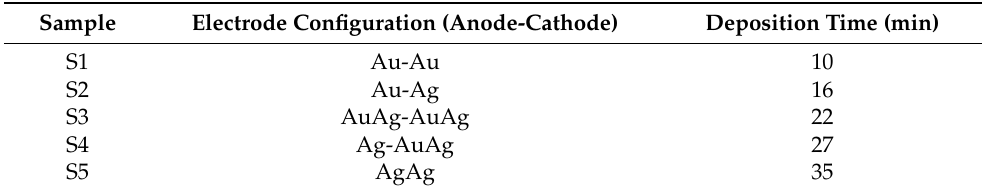
Figure 1. Schematic illustration of the experimental setup: the SDG chamber, in which the NP generation takes place ( 1 ), the tube furnace ( 2 ), and the impactor ( 3 ) used for depositing the NPs on the substrate (its placement marked with color). The arrows indicate the flow of the carrier gas and the aerosol. Table 1. The electrode configurations and deposition times were used for the fabrication of each